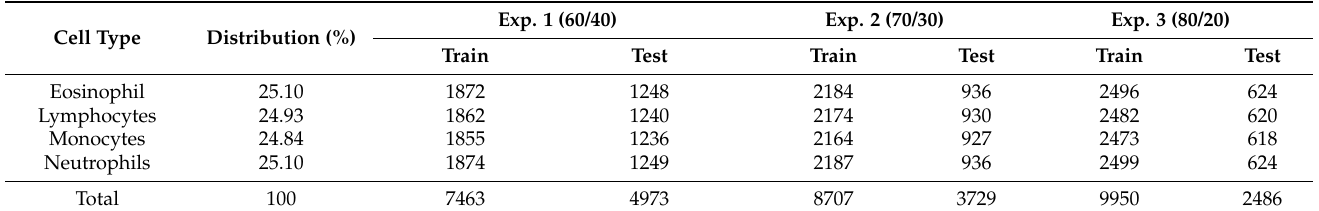
Table 2. Statistical specifics of WBC dataset utilized in this study. Three different experiments with different train/test split ratios are designed to evaluate the generalizability of the proposed